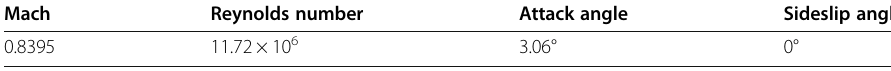
Table 5 Flow conditions of the ONERA M6 wing in Ref.